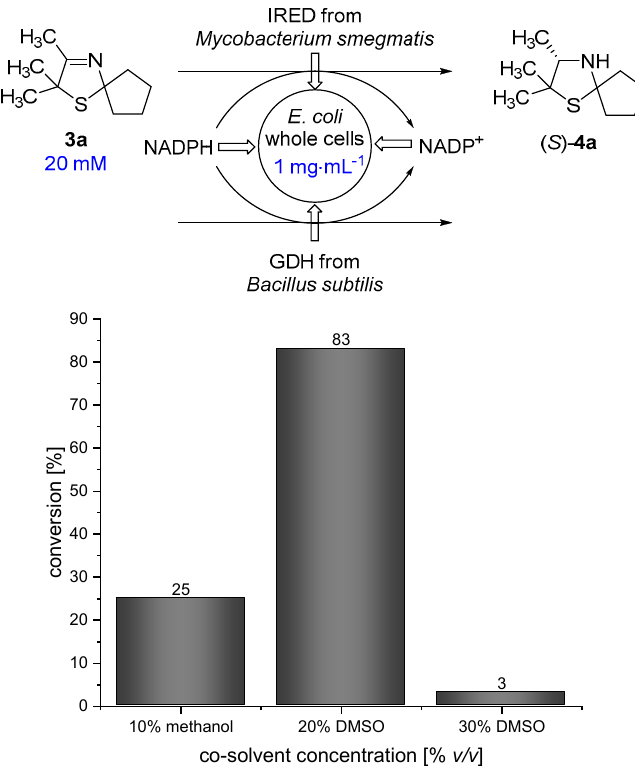
Figure 3. Results for the reduction of 3 ‐ thiazoline ( 3a ) using an E. coli whole ‐ cell catalyst in the presence of different amounts of methanol/dimethylsulfoxide (DMSO) as a co ‐ solvent.